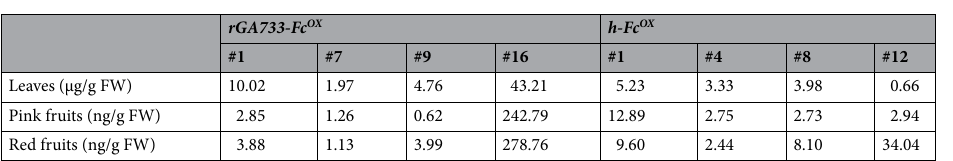
Table 1. Quantification of the rGA733-Fc and h-Fc protein in transgenic tomato plants. rGA733- Fc OX , rGA733-Fc overexpressing plants; h-Fc OX , human-Fc overexpressing transgenic plants.